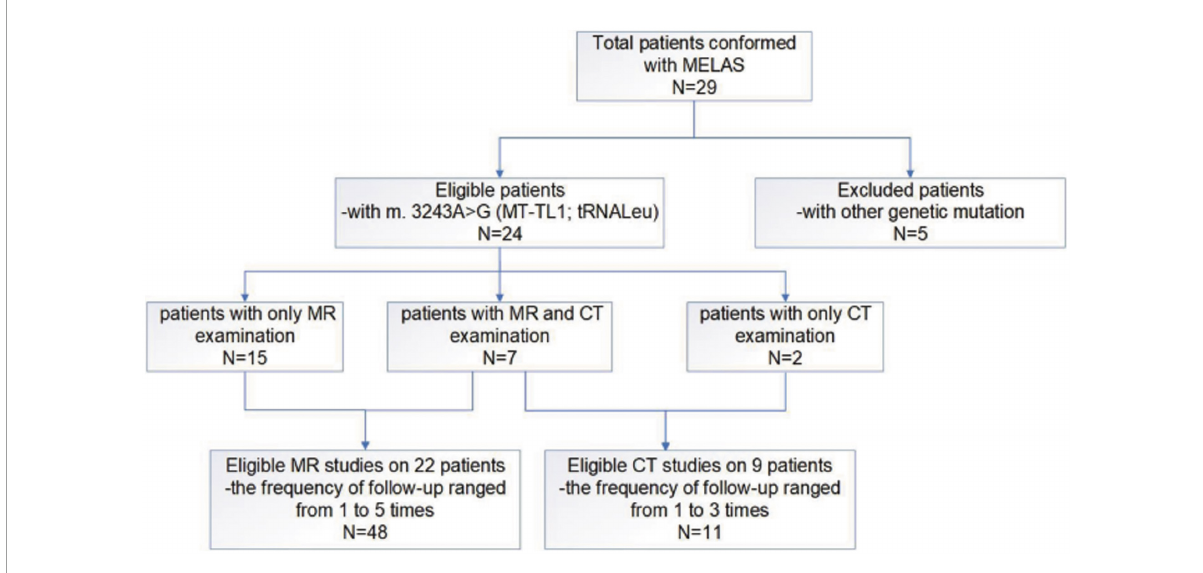
FIGURE1 A flow-chart of the entire work